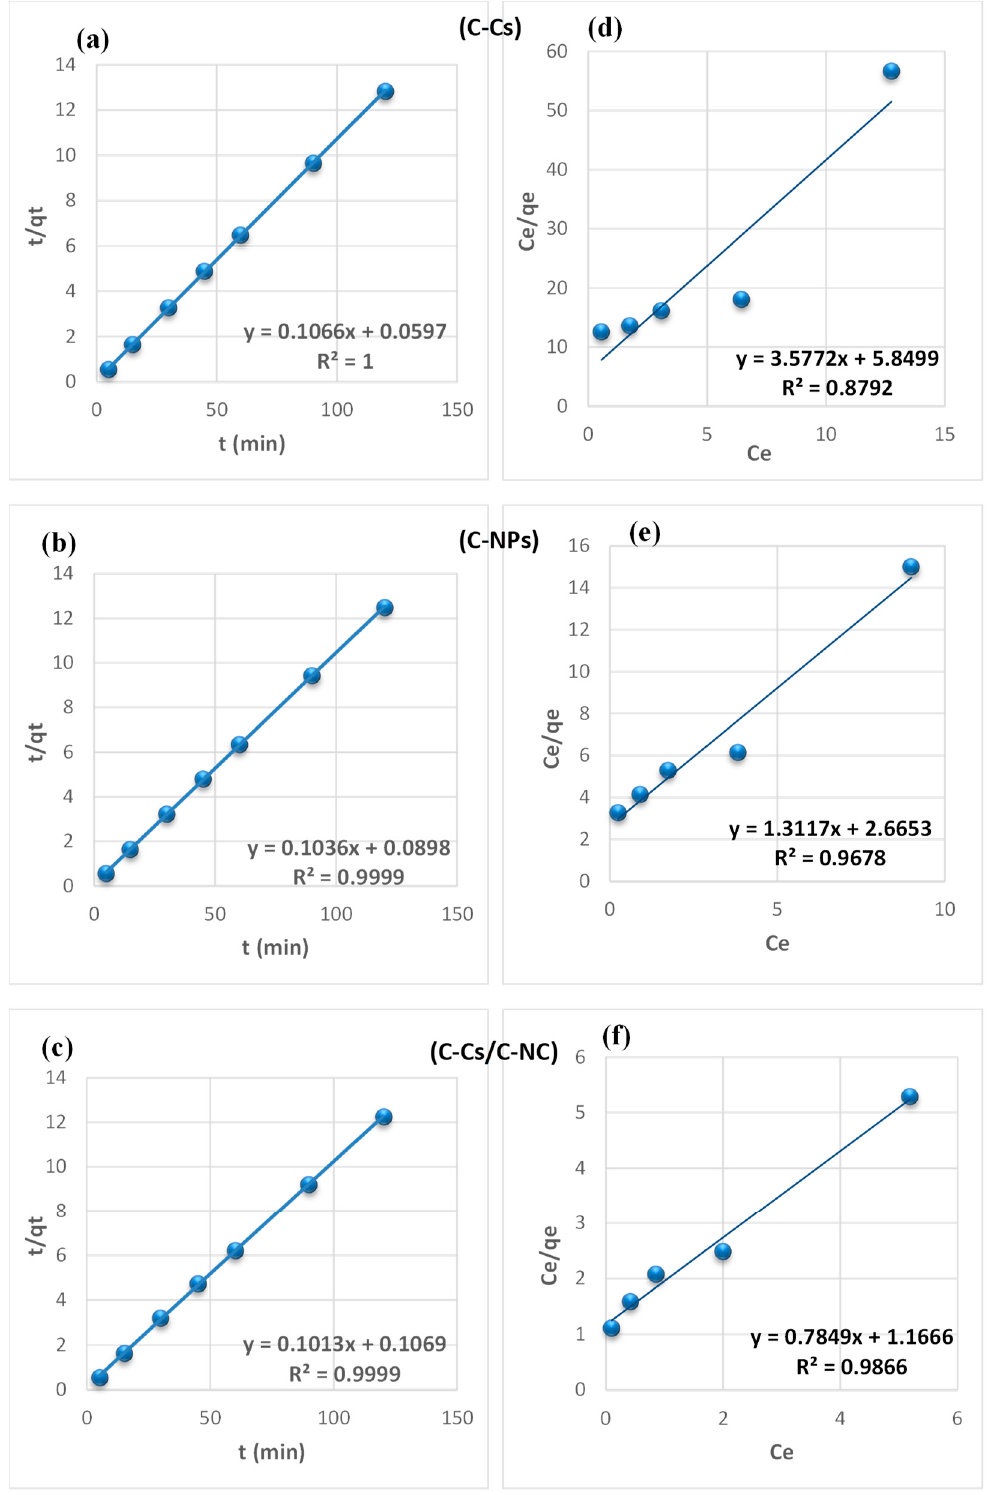
Figure 8. Pseudo-second-order fitting model ( a – c ) and Langmuir isothermal fitting model ( d – f ) of the removal of MB using C-Cs, C-NPs, and C-Cs/C-NC, respectively.